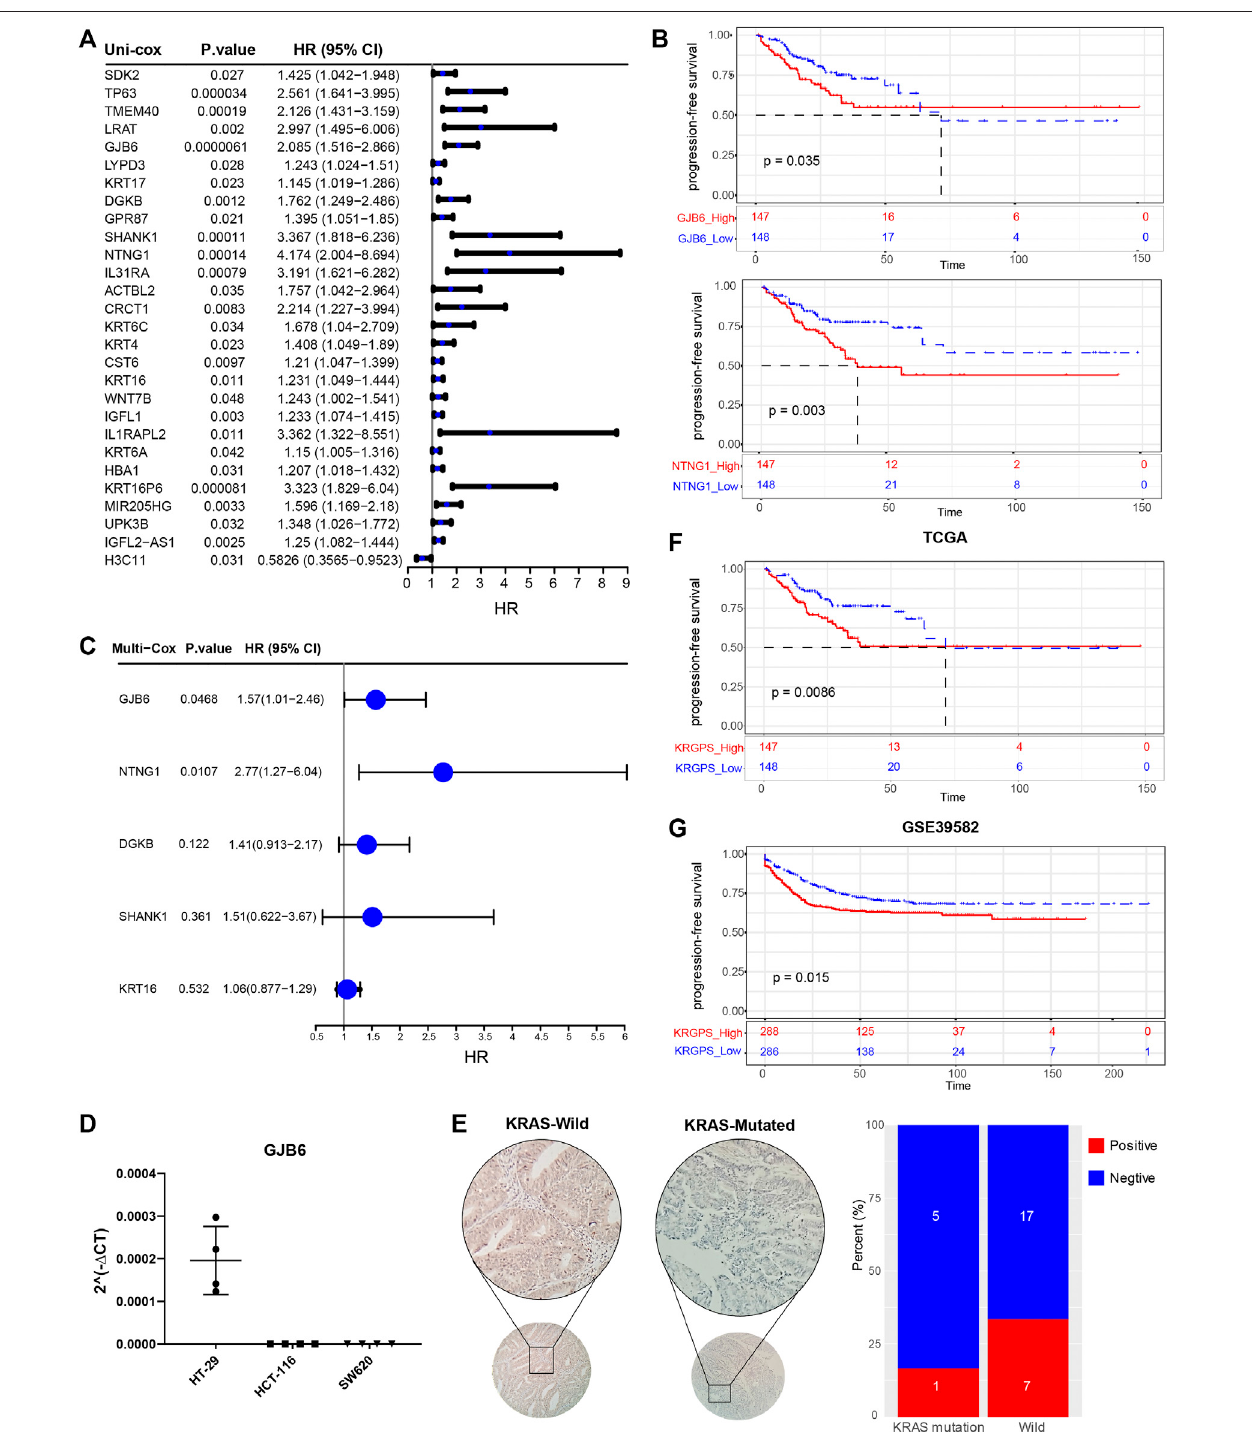
FIGURE 3 | Identi fi cation of prognostic signatures. (A) Univariate Cox analysis of 28 KRAS-related genes with p < 0.05. (B) Kaplan – Meier survival analysis of NTNG1 and GJB6 in TCGA cohort (p < 0.05) (C) Multivariate Cox regression analysis of 5 prognostic genes determined by Kaplan – Meier survival analysis. (D) RT-PCR validationofGJB6indifferentCOADcelllines.HT-29wasKRAS-wildwhileHCT-116(G13)andSW620(G12)wereKRAS-mutated (E) RepresentiveIHCresultsofGJB6 in CRC patients with KRAS mutated or not. Scale, 200x. Percent of GJB6 positive samples in KRAS-mutated and wild patients. (F) Kaplan – Meier survival analysis of KRGPS in the TCGA cohort (Log-rank test) (G) Validation of KRGPS in the GEO cohort by Kaplan – Meier survival analysis (Log-rank test).